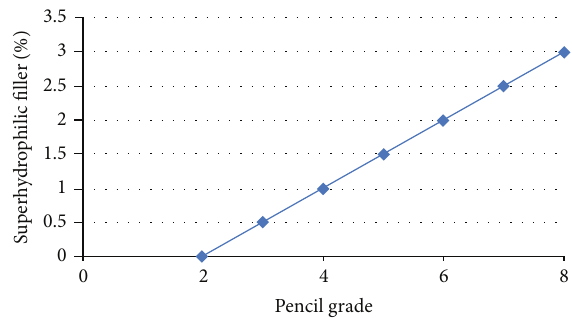
Figure 9: Influence of TiO 2 superhydrophilic photocatalysis filler percentages against pencil grade that can gouge the TOP